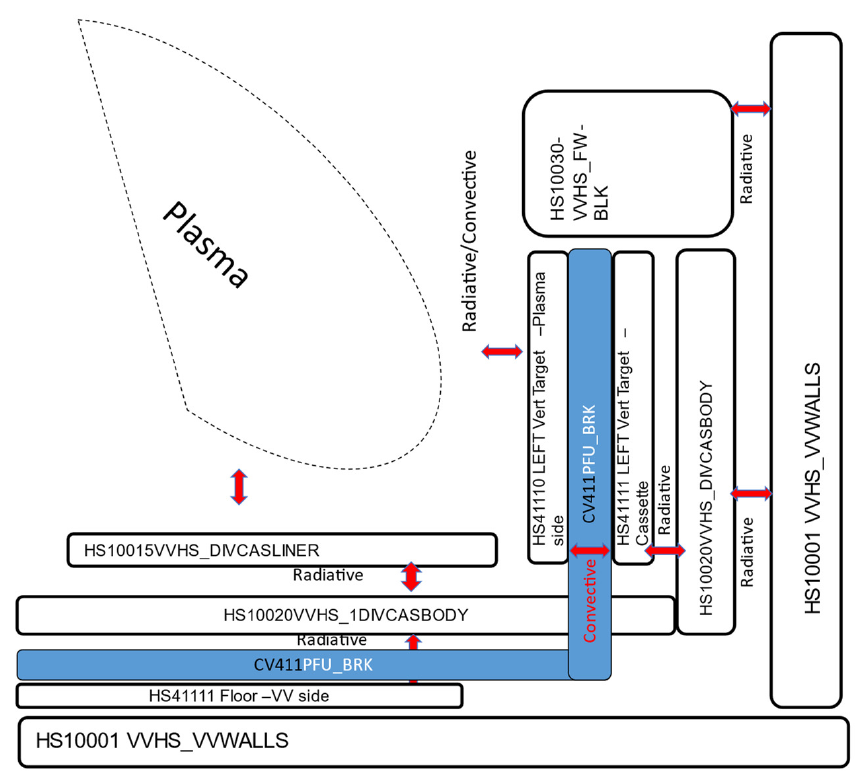
Figure 8. In-vessel heat structure coupling. Control Volumes (CV) are shown as blue shaded boxes, Heat Structures (HS) are shown as white boxes, red arrows show heat transfer mechanisms modeled across HS (FUN1 functions) or radiative towards plasma chamber.